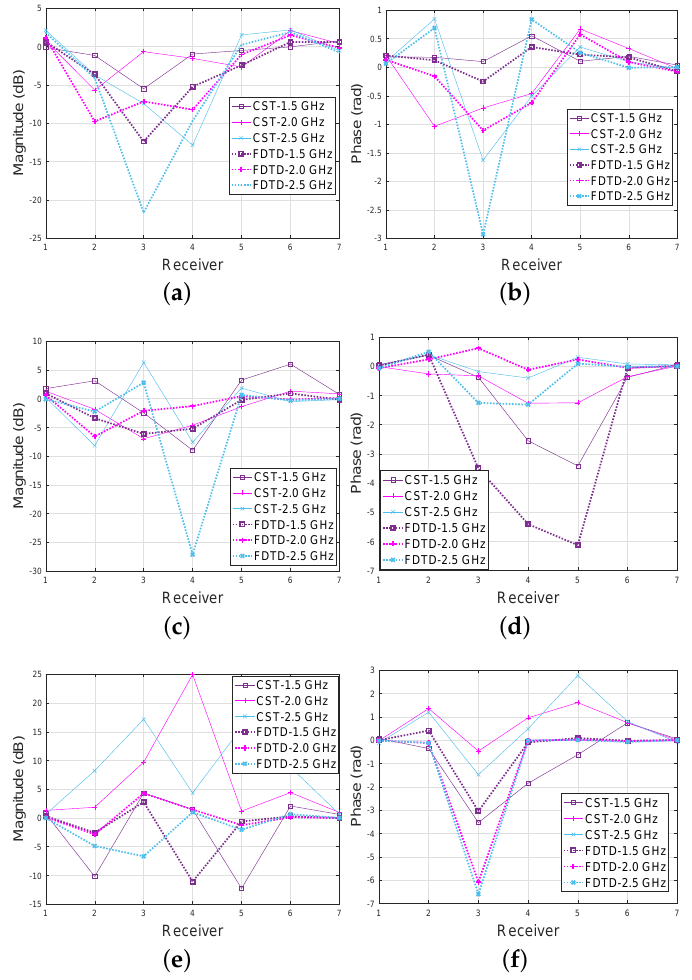
Figure 2. Amplitude (in dB) and phase differences due to the water-filled cylindrical target, recorded at each receiver for the first antenna used as transmitter, and for different background media. ( a , b ) Triton X-100; ( c , d ) 92% Corn syrup; ( e , f ) 80% Glycerine. The plots compare results from simulations of the physical experiment in CST Microwave Studio, using the computer-aided design (CAD) model of Figure 1c, with a 2-D simplified finite-difference time-domain (FDTD) model, which is also used as a forward solver in our imaging